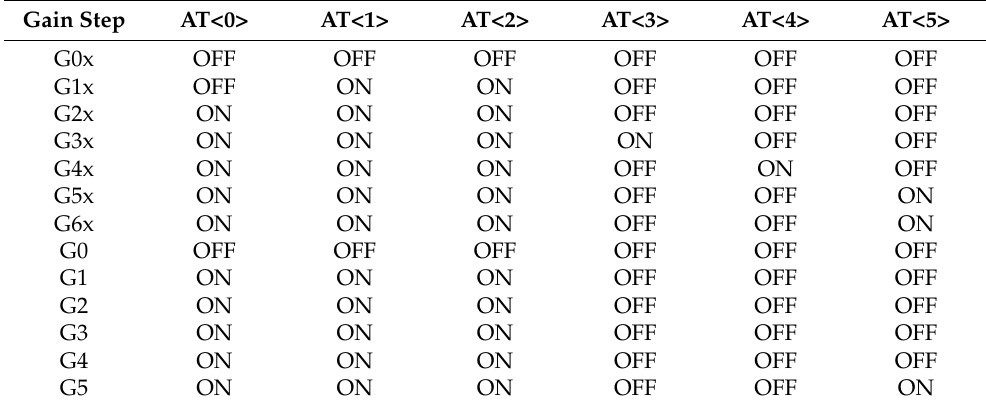
Table 3. Programmable digital control bits of the load switching and additional cascode